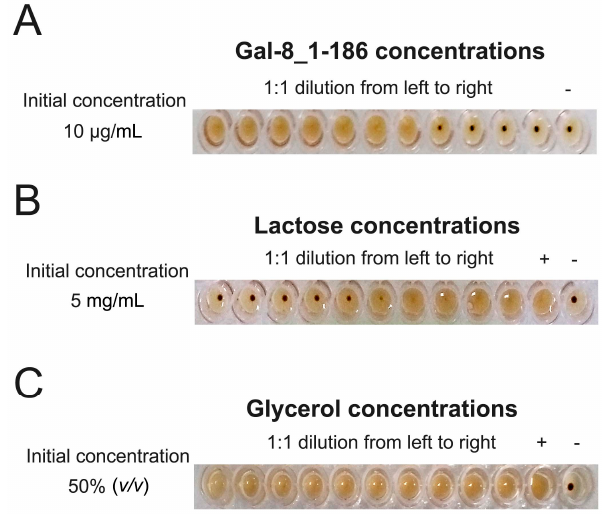
Figure 1. Gal-8_1-186 induces chicken erythrocyte agglutination assay. ( A ) Gal-8_1-186 induce agglutination of chicken erythrocytes with a MAC (Minimum Agglutination Concentration) value of 0.16 µg/mL. “ − ”represents the negative control well containing no protein; ( B ) the agglutination capability of Gal-8_1-186 was inhibited by lactose. 0.16 µg/mL Gal-8_1-186 was used in this assay. The MIC (Minimum Inhibition Concentration) of lactose is 0.63 mg/mL. “ − ”represents the negative control well containing no protein and lactose; “+”represents the positive control well containing no lactose; ( C ) the agglutination capability of Gal-8_1-186 was inhibited by glycerol. 0.16 µg/mL Gal-8_1-186 was used in this assay. Glycerol cannot inhibit the agglutination activity of Gal-8_1-186 even at 50% ( v / v ) concentrations. “ − ” represents the negative control well containing no protein and glycerol; “+” represents the positive control well containing no glycerol.